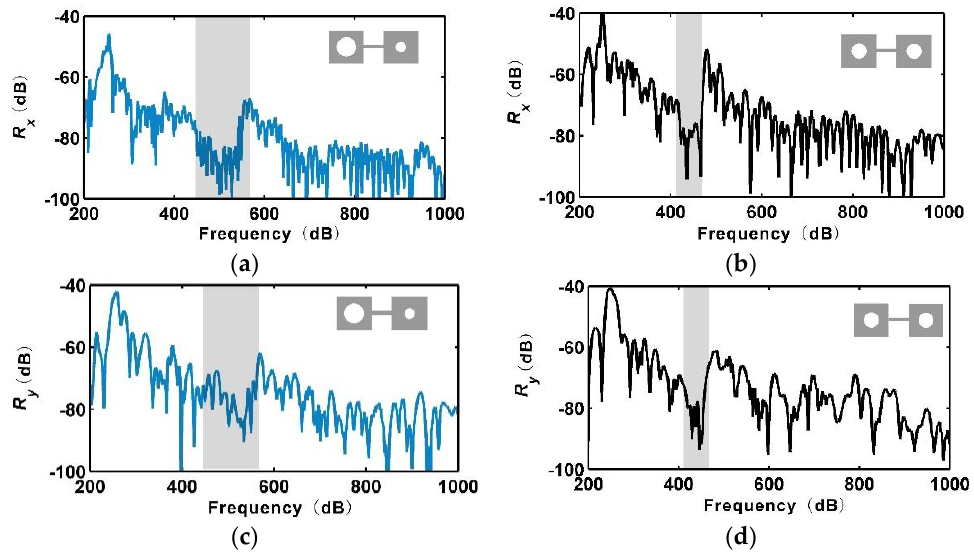
Figure8. Experimentalreceptancefunctionsoftherainbowmetamaterialinthe x -( a )and y -( c )directions, Figure 8. Experimental receptance functions of the rainbow metamaterial in the x- ( a ) and y- ( c ) and of the periodic metamaterial in the x - ( b ) and y- ( d ) directions. The bandgaps are marked in directions, and of the periodic metamaterial in the x- ( b ) and y- ( d ) directions. The bandgaps are marked in grey.